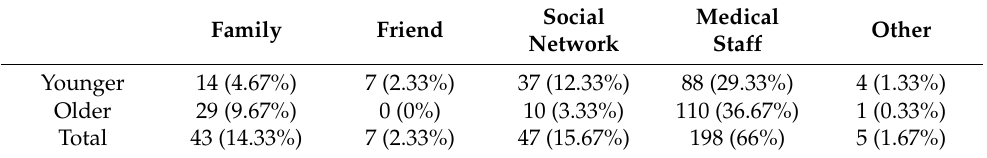
Table 3. The most important source of information about vaccination and vaccines.